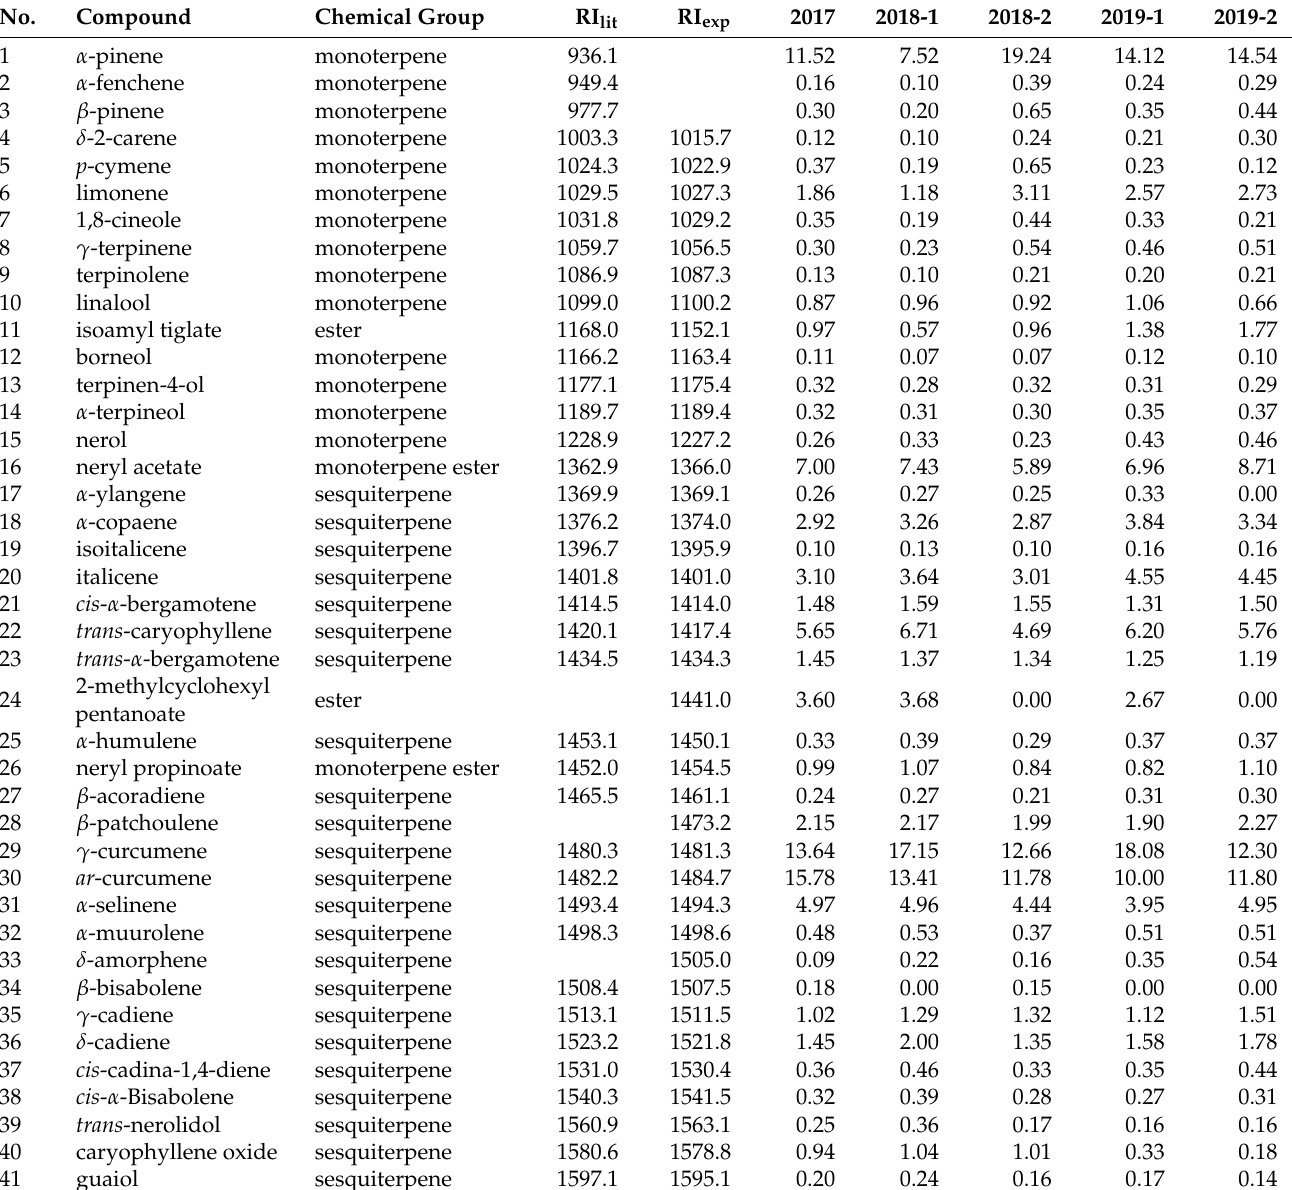
Table 2. Composition of immortelle EO during the three-year period (in